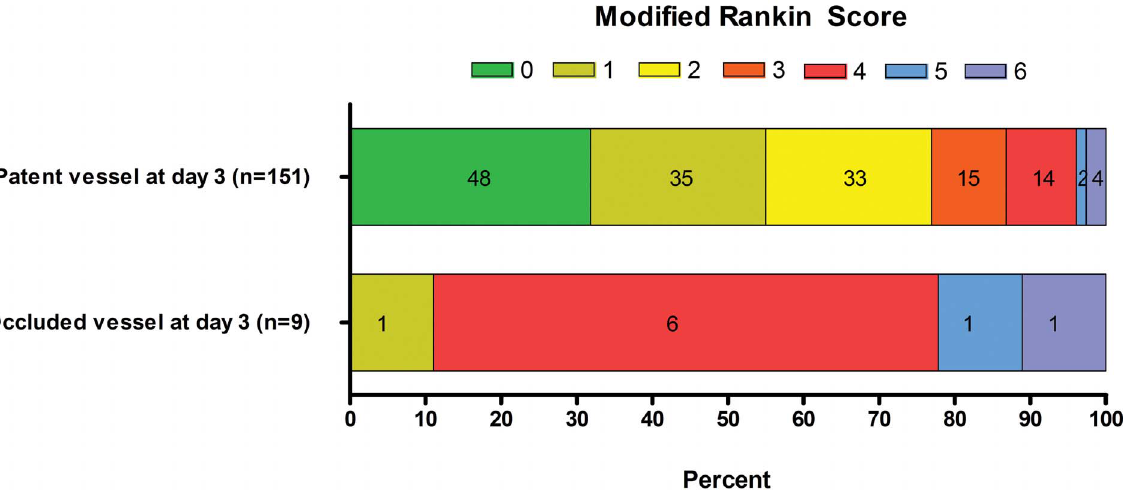
Figure 2. Modified Rankin Scale score distribution at day 90 of stroke according to presence of patent vessel (TIMI 2–3) or occluded vessel (TIMI 0–1) at day 3.